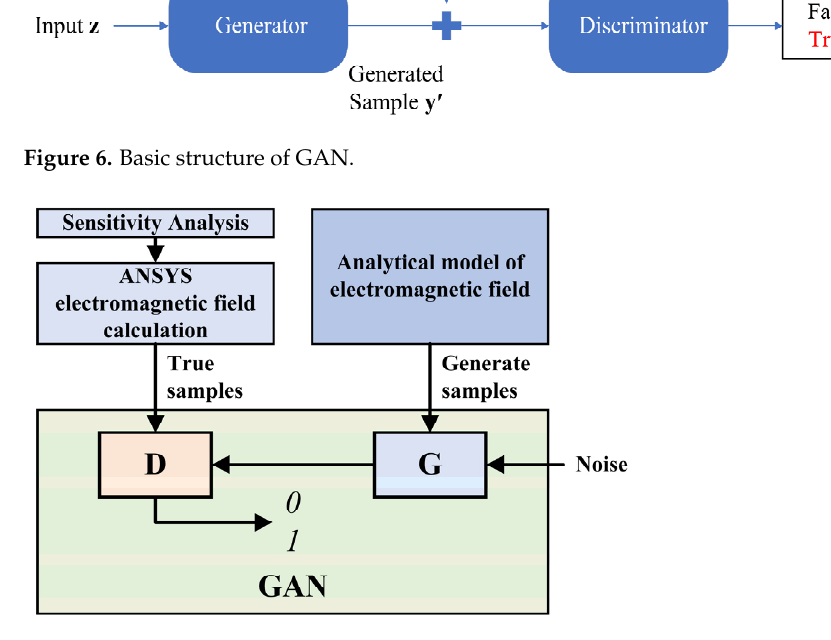
Figure 7. Basic structure of GAN in electromagnetic field.